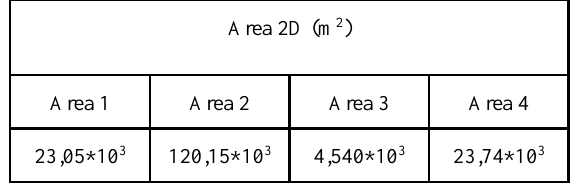
Table 3. Size in m 2 of the four focus areas.